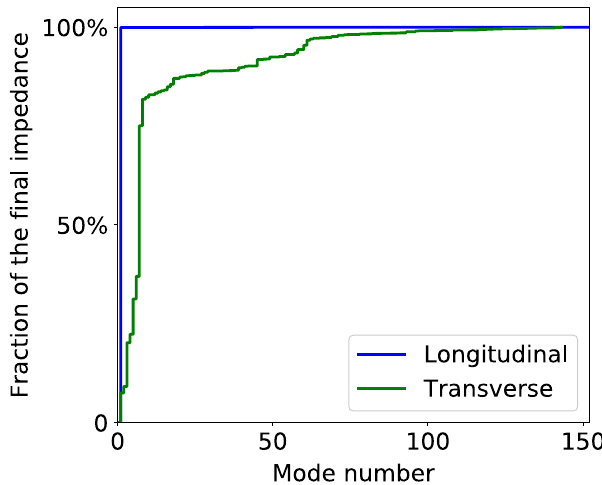
FIG. 7. Convergence check for the circular pipe structure depicted in Fig. 5.